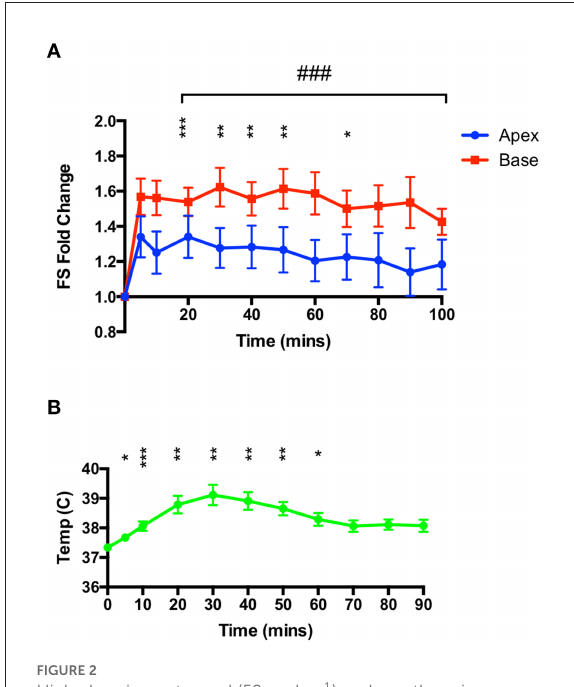
FIGURE2 High-dose isoproterenol (50mg.kg − 1 ) under euthermic conditions does not result in TTS-like contractility. (A) 50mg.kg − 1 isoprenaline under ketamine-midazolam anesthesia resulted in a significant positive inotropic response in both apical and basal myocardial segments, although not for all time-points in the apex. No significant difference was seen between apical and basal contractility ( n = 8). * P < 0.05, ** P < 0.01, *** P < 0.001 vs. baseline (apex); ### P < 0.001 vs. baseline (base) two-way repeated measures ANOVA. (B) Rectal temperature increases after isoproterenol, although this is attenuated by removing heating from the animal. * P < 0.05, ** P < 0.01, *** P < 0.001 relative to time 0, one-way ANOVA ( n = 8 animals).